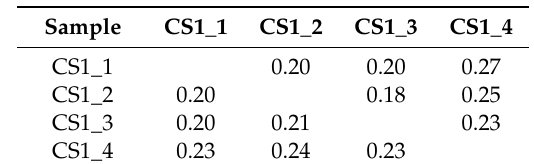
Table 3. Kolmogorov–Smirnov distance (KS-D) values of sample comparisons from case study 1, sample in question in first line.